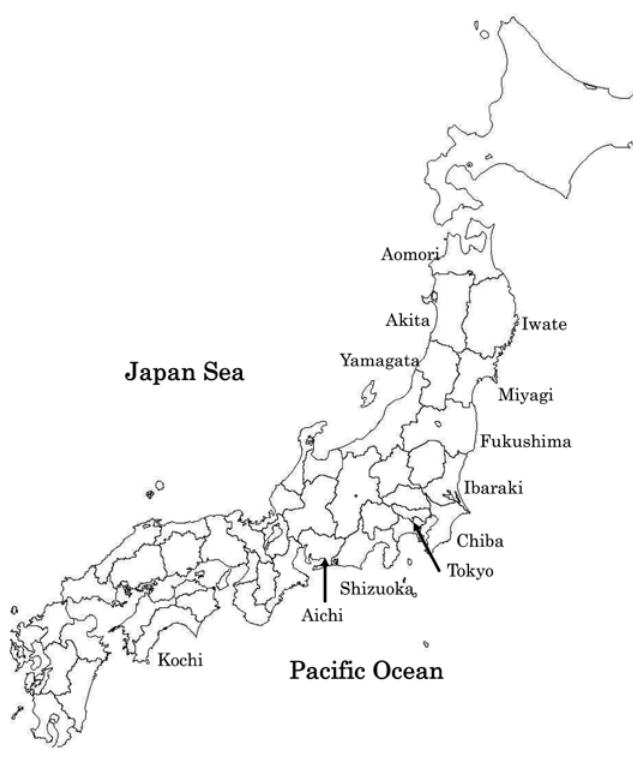
Fig. 3 - Major prefectures in